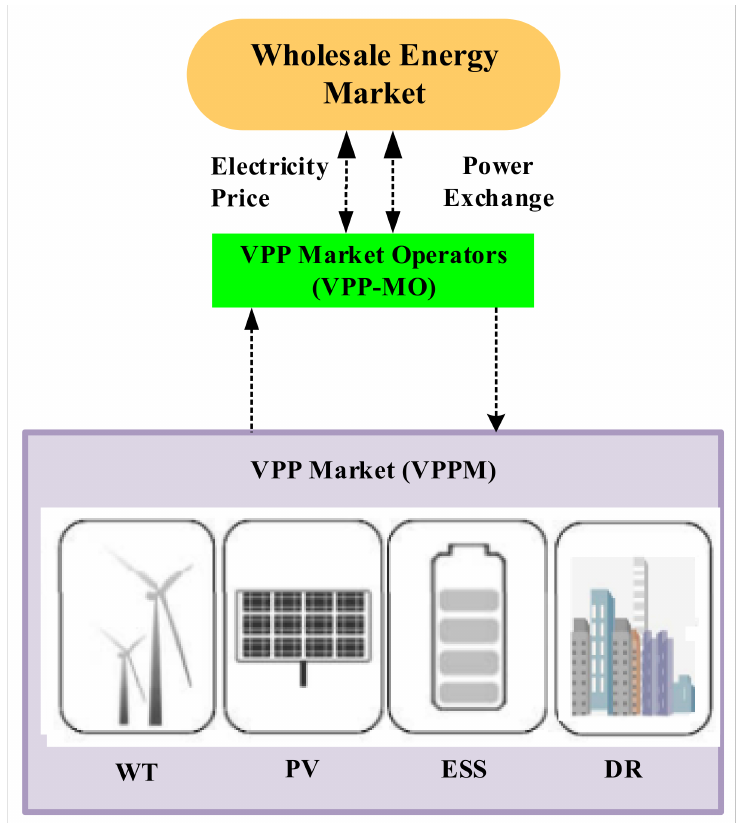
Figure 3. Proposed VPP electricity market structure.